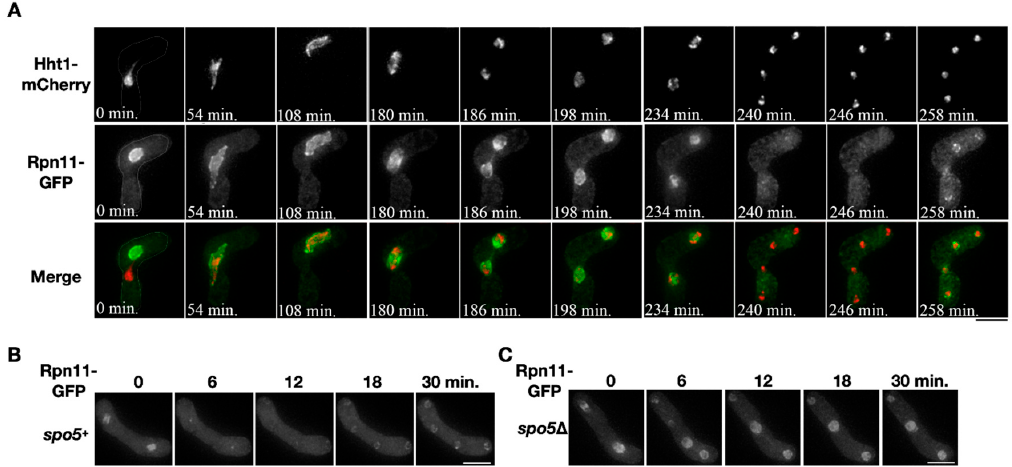
Figure 1. Diffusion of nuclear Rpn11 in anaphase II depends on virtual nuclear envelope breakdown (vNEBD). ( A ) A representative time-course image of the chromosome marker Hht1-mCherry (red) and Rpn11-GFP (green) throughout meiosis in the heterothallic mating cell. ( B,C ) Time-course observation of Rpn11-GFP in the wild type or spo5 Δ mutant during anaphase II. Scale bar: 5 µm.